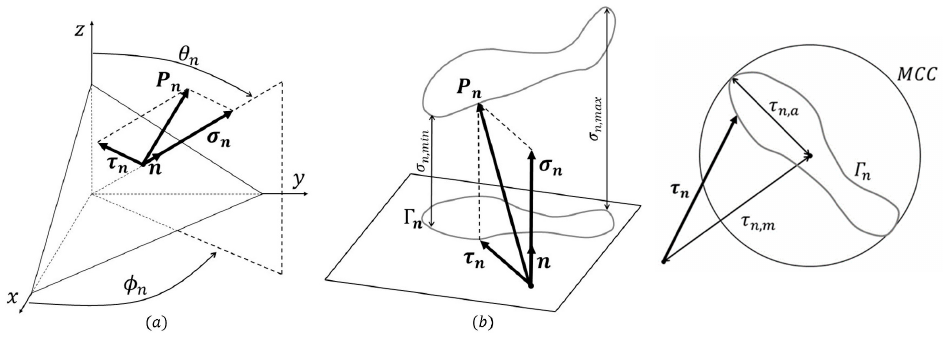
Figure 4. Minimum Circumscribed Circle method applied at the curve 훤 of 휏 , and 휏 , . At this point, for each plane having normal n that can be def Figure 3. ( a ): components of vector 푷 풏 ( 휙 , 휃 , 푡 ) on plane defined by 풏 ( 휙 , 휃 ) . ( b ): definition of ( 휙 휃 ) i i l 훤 h i Figure 5. ( a ): Components of vector (cid:126) P n in plane defined by (cid:126) n . ( b ): Definition of curve Γ n that is the projection of positions of (cid:126) P n assumed in a load cycle in plane defined by (cid:126) n or positions of θ n assumed in a load cycle. Individuation values of maximum and minimum normal stress and definition of τ n , a and τ n , m according to the MCC